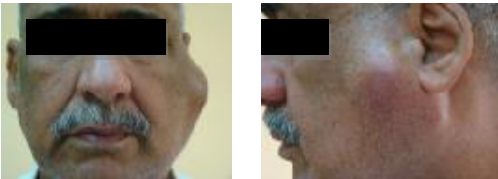
Figure 5: Patient with a big left parotid